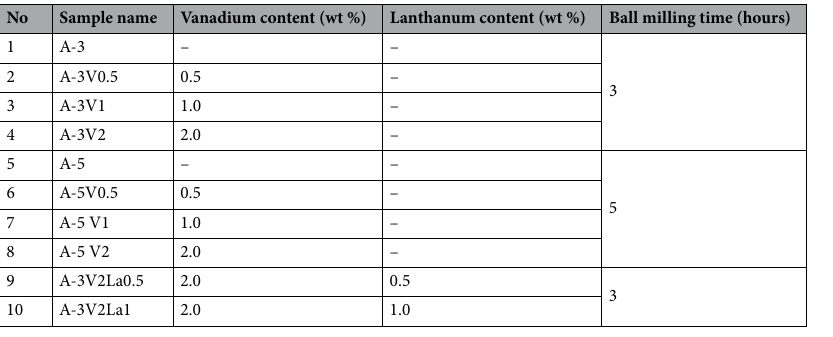
Table 1. List of prepared